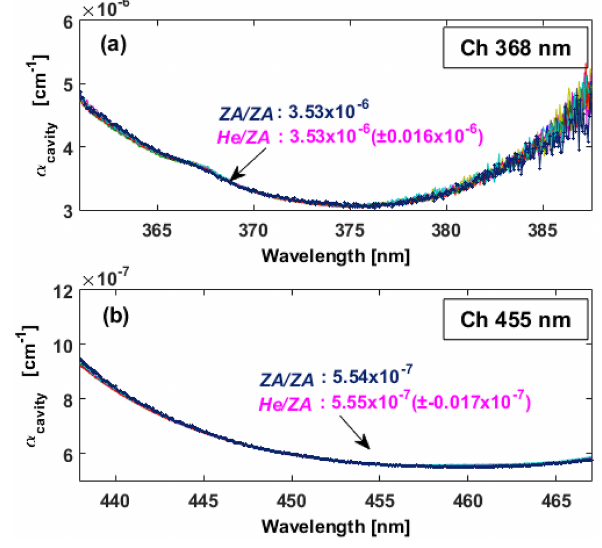
Figure 4. Cavity loss, α cavity (λ) = ( 1 − R(λ))/d determined using two methods: (1) He and dry zero air (He / ZA; magenta) and (2) ZA at two different pressures (ZA / ZA; dark blue). The data are from one SENEX research flight on 5 July 2013. The mean ( ± 1 σ) at 368 and 455nm pixels for 13 repetitions of He / ZA during level flight legs are (3.534 ± 0.016) × 10 − 6 and (5.551 ± 0.017) × 10 − 7 cm − 1 , respectively, shown as magenta text with varying colored lines. The estimation at those wavelengths from ZA / ZA using 390 and 812hPa pressure (3.53 × 10 − 6 and are 5.54 × 10 − 7 ) is in good agreement with He /